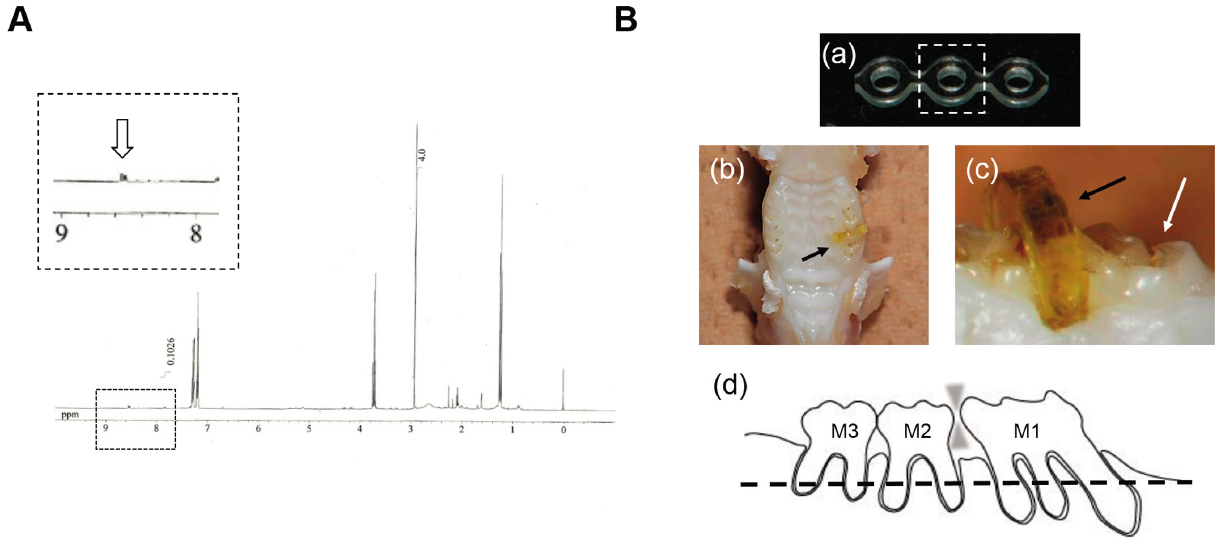
Figure 1. Prepared TSCs and experimental tooth movement model. ( A ) 1 H NMR spectra of the comprehensive mixture of tobacco smoke components (TSCs) containing tar and nicotine. The arrow in the magnified area represents the specific spectra of nicotine; ( B ) Representative images of the experimental tooth movement model in the rat. ( a ) Intact power chain (PC). Broken-line square: part used in the animal experiments; ( b , c ) Macro-images obtained from occlusal and lateral views. Black arrow: PC discolored by TSC administration. White arrow: first molar (M1). PC was inserted unilaterally between the first and second molars; ( d ) Scheme of the sagittal two-dimensional section of PC-inserted dentition in maxillary alveolar bone. The broken line represents a plane used in the following micro-computed tomography ( μ CT) image and histological section in Figure